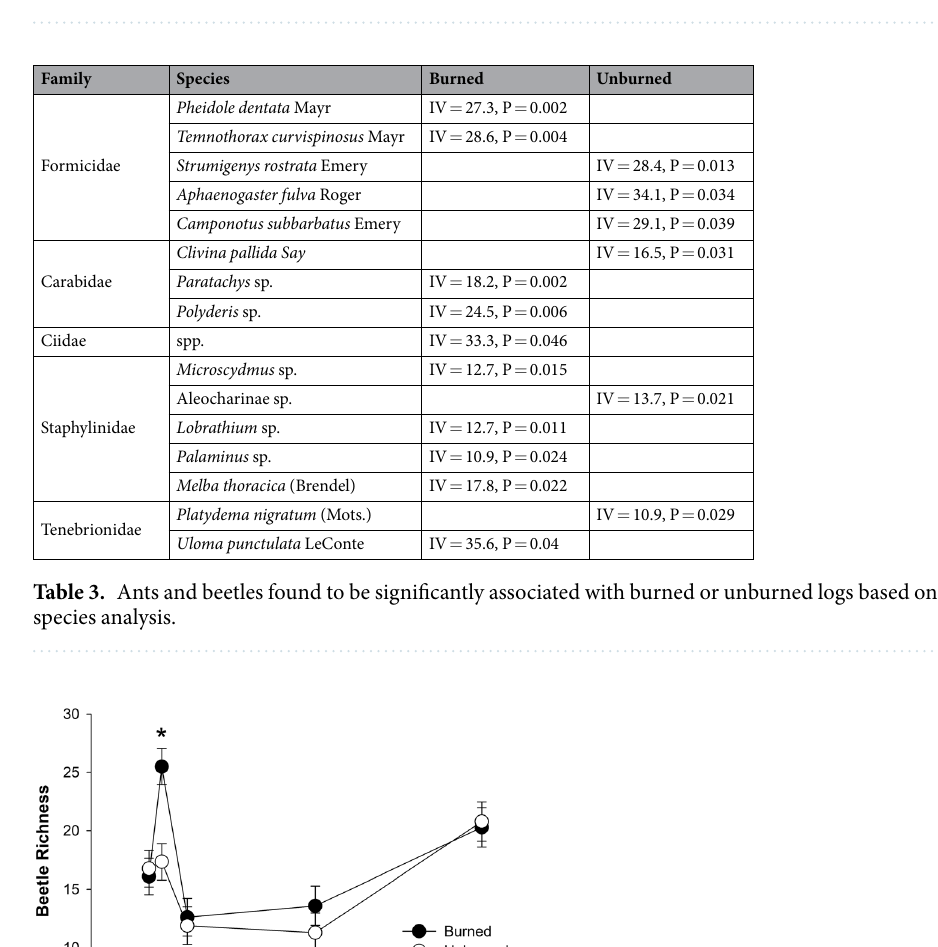
Table 2. Results from mixed models with asterisks denoting significance ( * P < 0.05, ** P < 0.001, *** P < 0.0001). Termites (present/absent) and log diameter were non-significant and thus removed from all models.